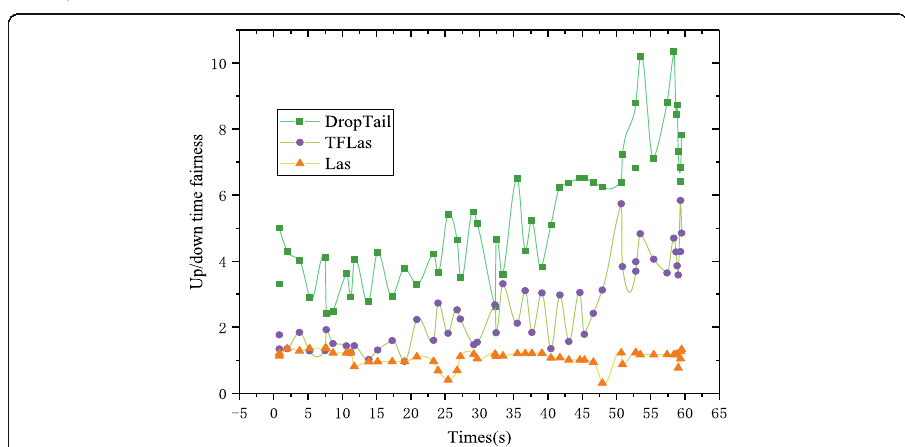
Fig. 3 Each up/down flow ’ s average holding time ratio in the